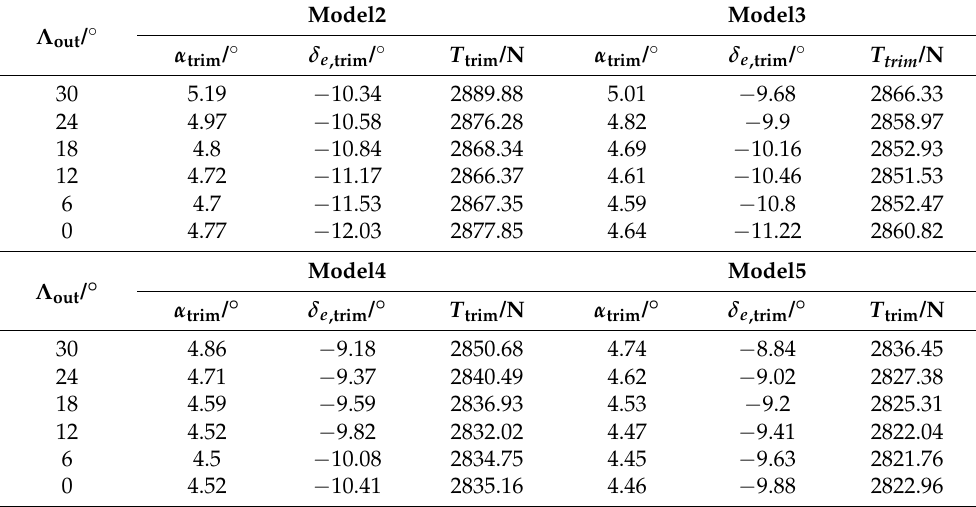
Table 6. The trim state corresponding to some configurations of the pre-selected models when Ma =